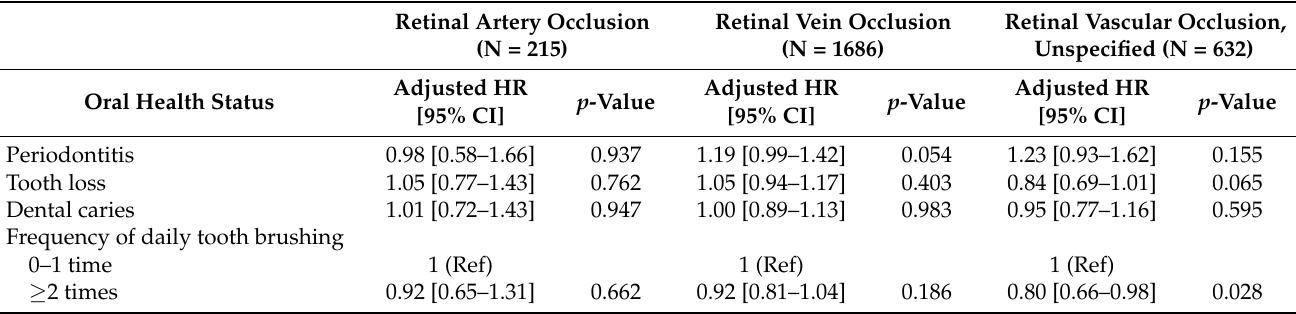
Table 3. Secondary outcome analysis for individual